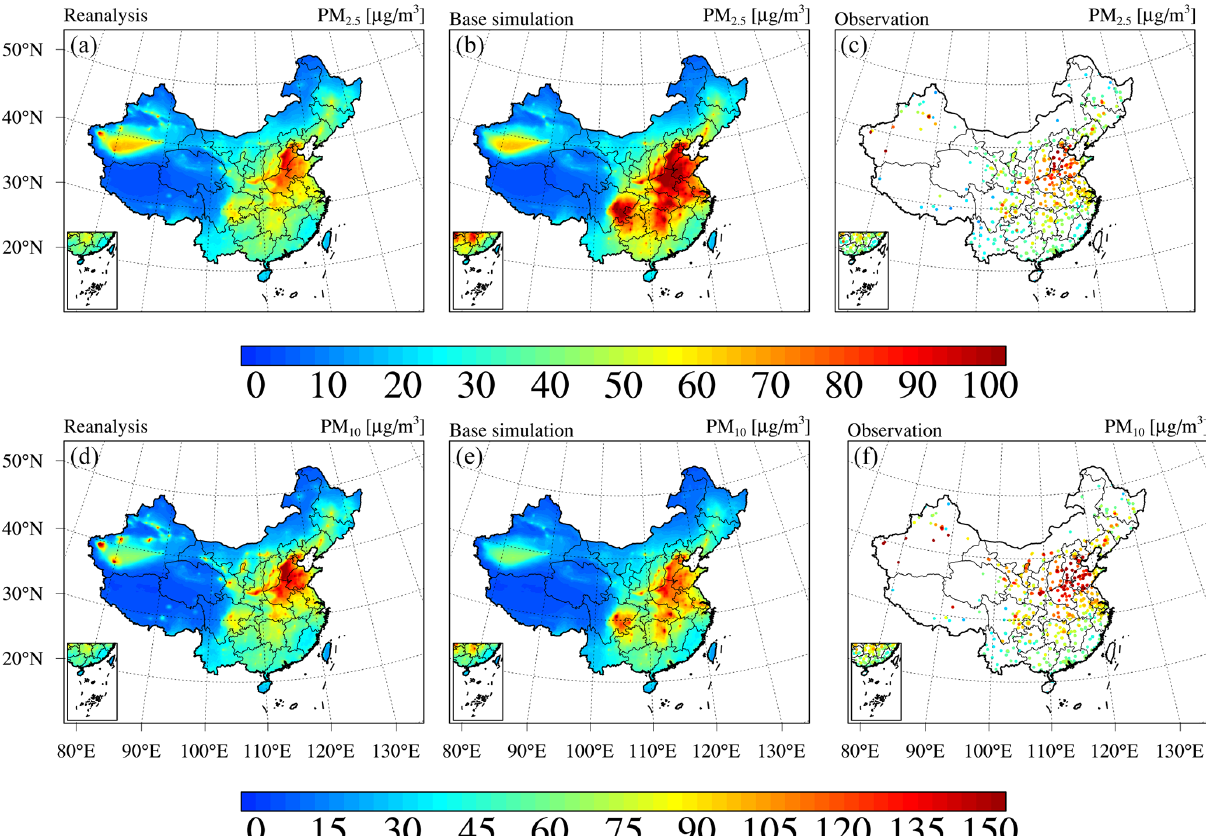
Figure 5. Spatial distributions of the (a–c) PM 2 . 5 and (d–f) PM 10 concentrations in China from (a, d) CAQRA, (b, e) the base simulation, and (c, f) observations averaged from 2013 to